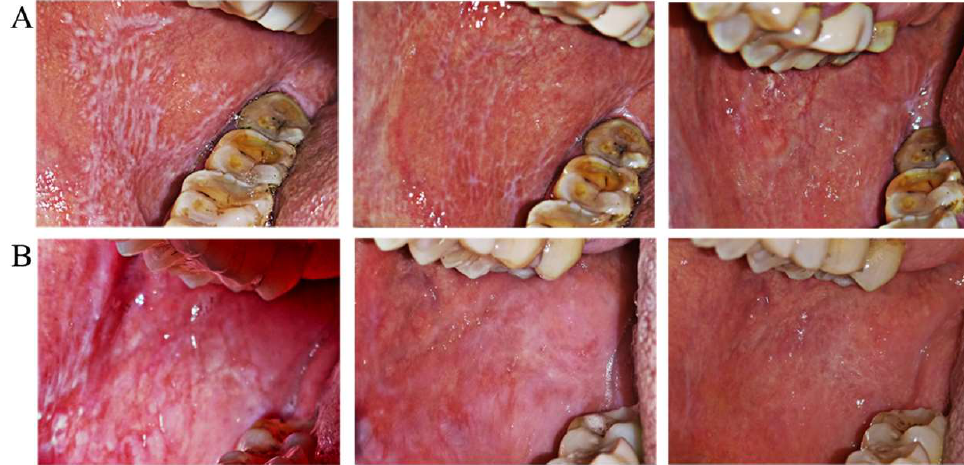
Figure 4. Magnitude of clinical responses of non-erosive OLP to dexamethasone plus gentamycin mouthwash ( A ) and dexamethasone plus gentamycin mouthwash combined with TGP capsules ( B ). The left panel is the clinical presentation at the initial baseline, the middle panel is the clinical presentation at the 1-month follow-up, indicating improved white lesions, and the right panel is the clinical presentation at the 6-month follow-up, when only a few white lesions remained (upper, Group A) or they had disappeared (upper, Group B). Table 6. Comparison of treatment effective rate between two groups with non-erosive and ero- sive